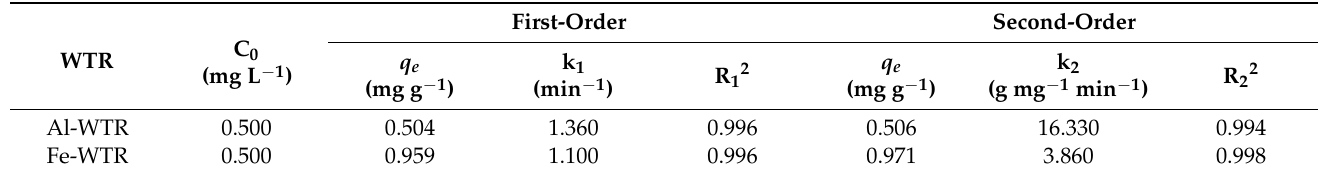
Table 2. Adsorption kinetic model parameters of Fe-WTR and Al-WTR for Tl(I).